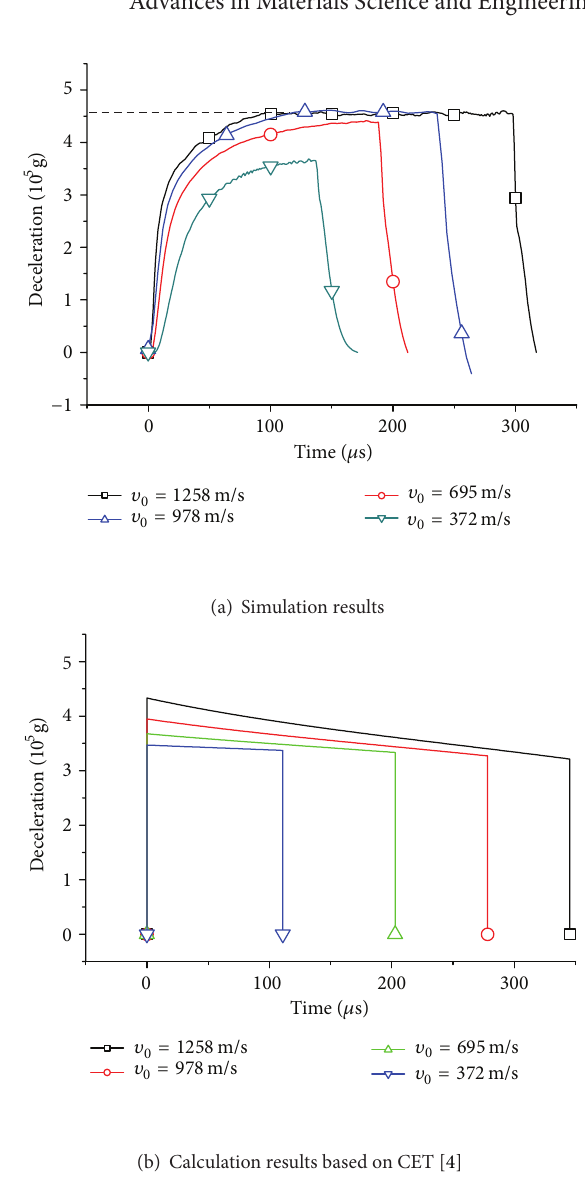
Figure 5: Deceleration versus time of projectile with different striking